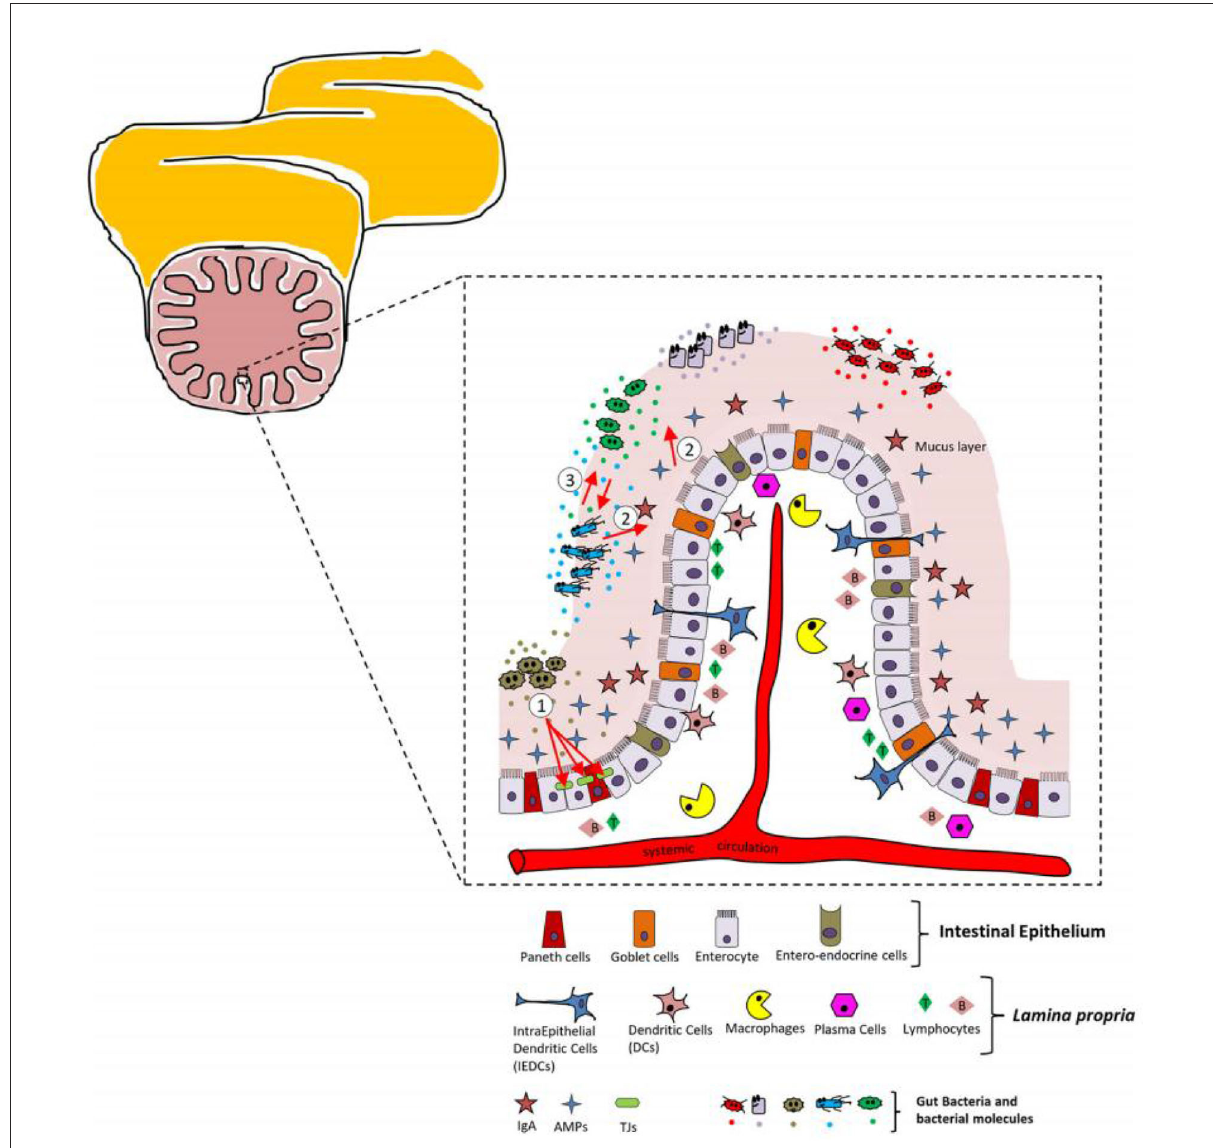
FIGURE6 Schematic representation of the intestinal barrier and major cellular players.